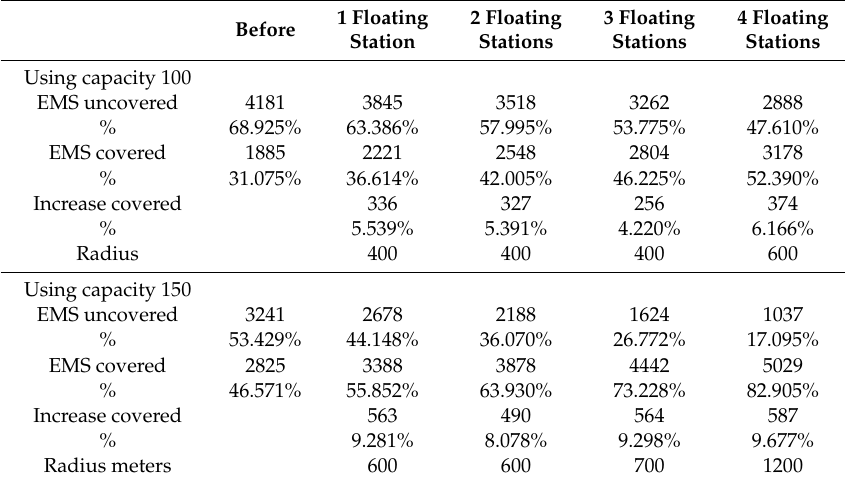
Table 2. Results of the four floating stations